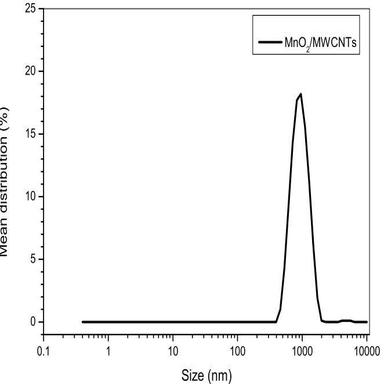
Particle size distribution of MnO2/MWCNTs composites.